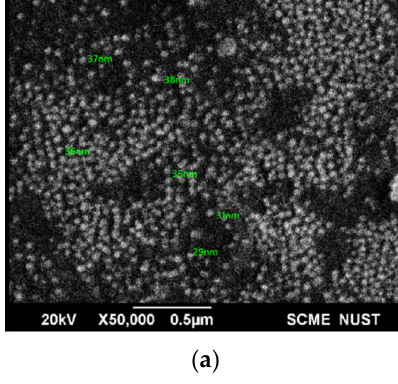
Figure 3. ( a ) SEM image of AgNPs; ( b ) SEM image of CIP-AgNPs.